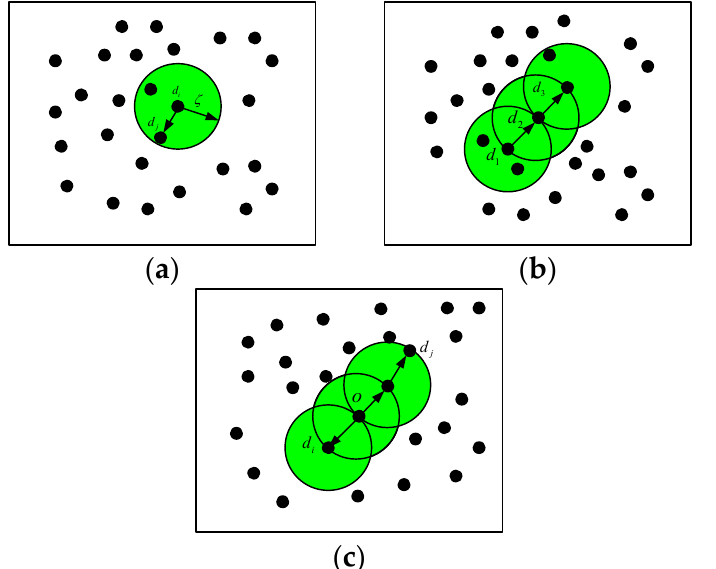
Figure 2. DBSCAN ( a ) directly density reachable, ( b ) density reachable, and ( c ) density connected. Assume a sample set,